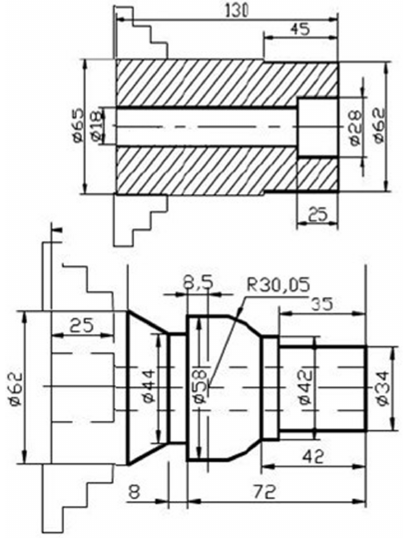
Figure 3. Shaft parts process